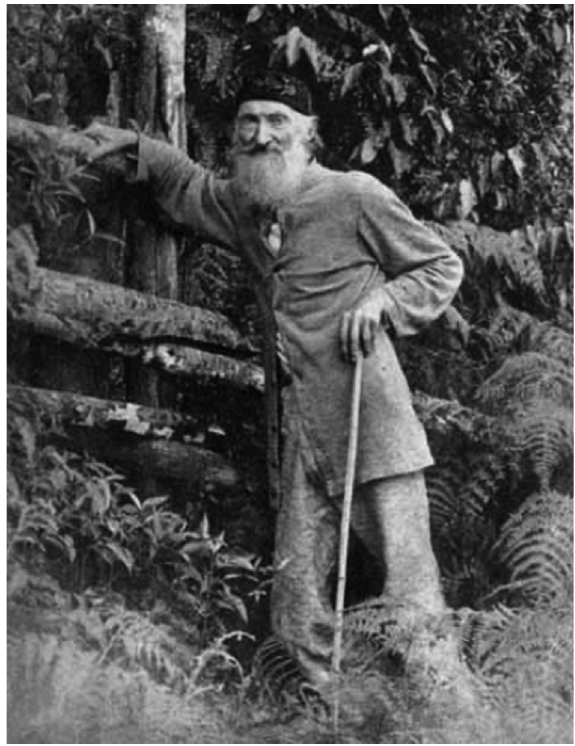
Figure 1 - Fritz Müller (1822-1897). This is one of his best-known por- traits, probably taken near his house in